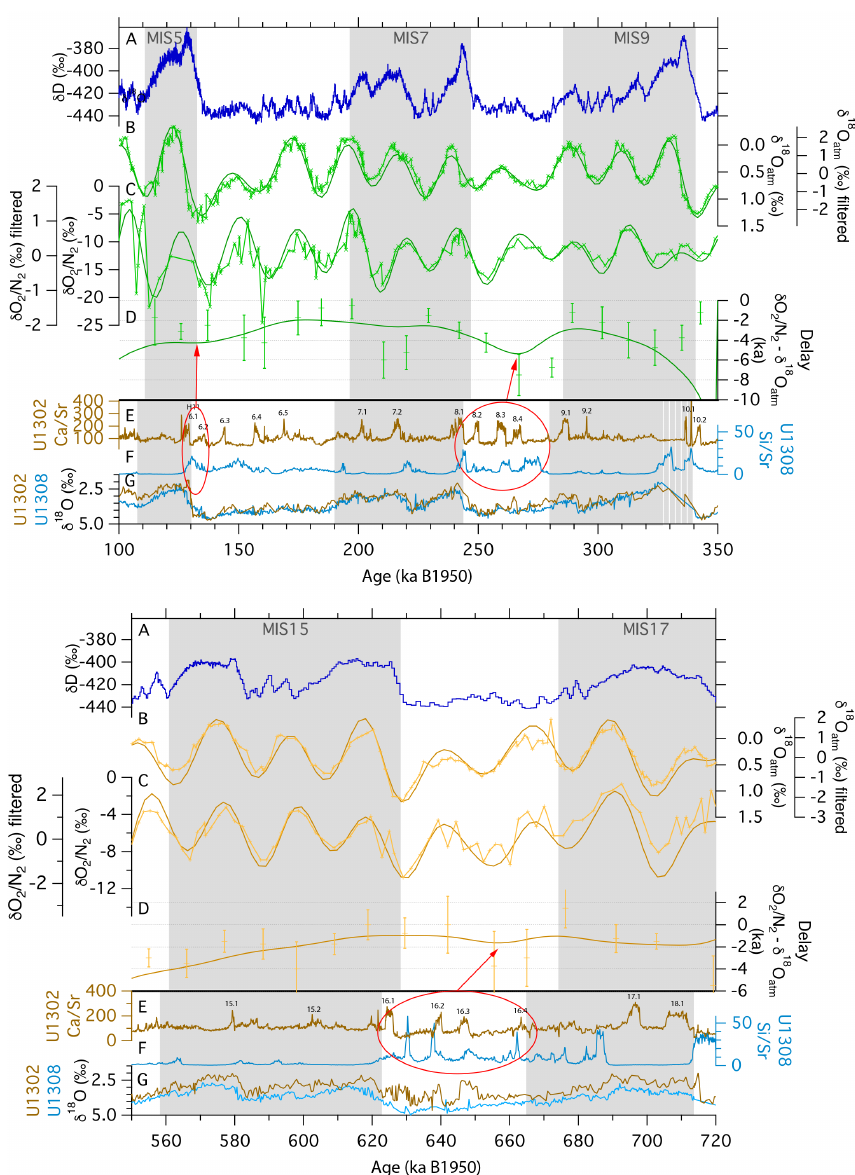
Figure 4. Evolution of the time delay between δ O 2 / N 2 and δ 18 O atm for the periods 100–350ka (top) and 550–720ka (bottom). The Vostok data are represented in green and EDC data in yellow. The filtered data are first normalized (minus the mean and divided by the standard deviation) and then filtered using a bandpass filter with 15–100ka period pass band and wavelet transform in Matlab. Curves A to D correspond to Vostok and EDC ice cores data on the AICC2012 chronology. A: δ D of EDC, B: δ 18 O atm on reversed axis (line with markers for raw data and plain line for filtered data), C: δ O 2 / N 2 (line with markers for raw data and plain line for filtered data), D: time delay calculated between δ O 2 / N 2 and δ 18 O atm using Matlab (plain curve) and manually (markers with error bars). Curves E to G present data from the U1202/03 (brown) and U1308 (light blue) marine cores presented on their respective chronology. E: Ca / Sr ratio, F: Si / Sr ratio, G: δ 18 O planktonic for U1302/03 and δ 18 O benthic for U1308. The grey rectangles mark the MIS intervals in both archives. The numbering in curve E corresponds to the identification of Heinrich-like events as recorded by the Ca / Sr ratio of core U1302/03 and as proposed by Channell et al. (2012). The red circles and arrows show the correspondence between the ice sheets discharge events in the marine records with the maximum delay between δ O 2 / N 2 – δ 18 O atm